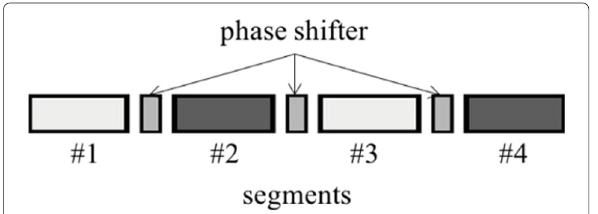
Fig. 29 Schematic drawing of a new type of the SCU [34]. The light source is composed of four undulator (ID) units and three